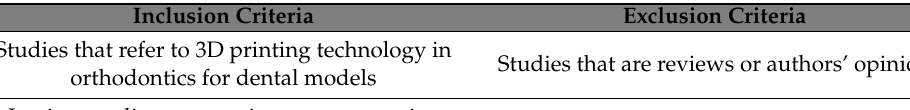
Table 2. Inclusion and exclusion